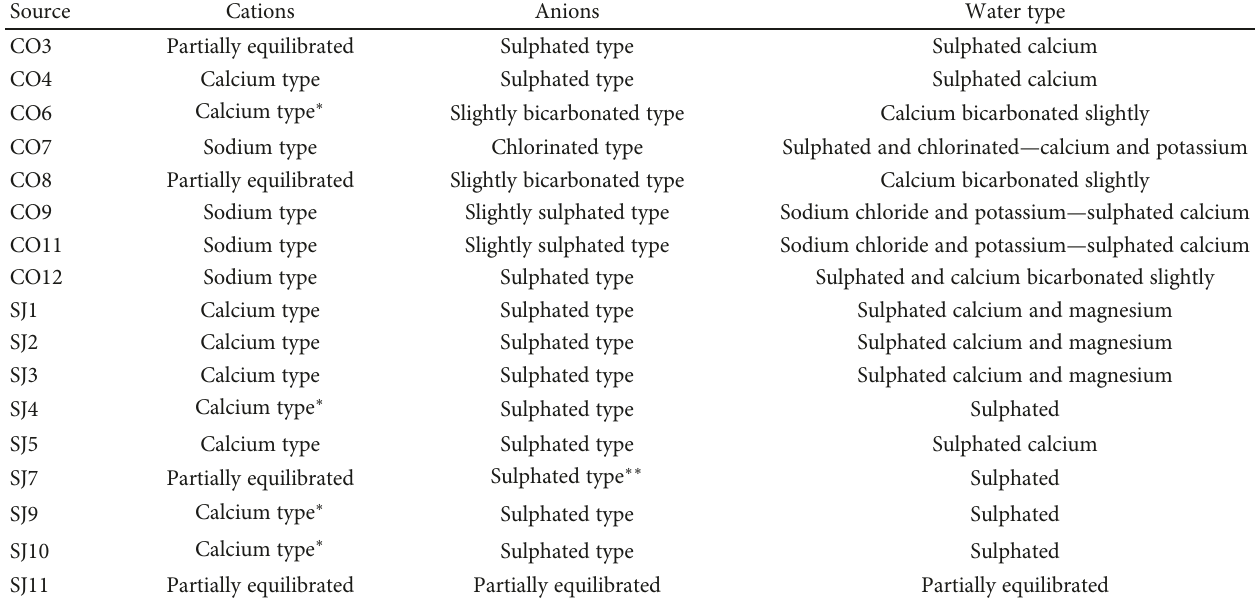
Table 4: Chemical classi fi cation of waters of the San Juan sector, according to cations, anions, and water